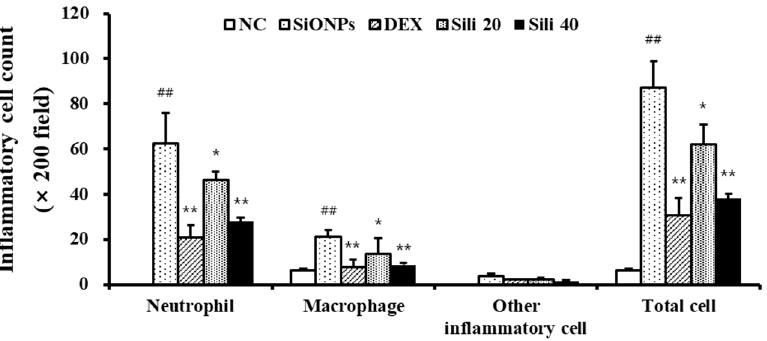
Figure 4. Inflammatory cell counts of the bronchoalveolar lavage fluid (BALF) from mice exposed to SiONPs. NC, normal control mice treated with PBS only; SiONPs, mice treated with SiONPs intranasal instillation; DEX, mice treated with dexamethasone (2 mg/kg) + SiONPs intranasal instillation; Sili 20 and 40, mice treated with silibinin (20 and 40 mg/kg, respectively) + SiONPs intranasal instillation. Data are represented as means ± SD ( n = 6). ## p < 0.01 vs. NC group, * , ** p < 0.05 and < 0.01 vs. SiONPs group, respectively.